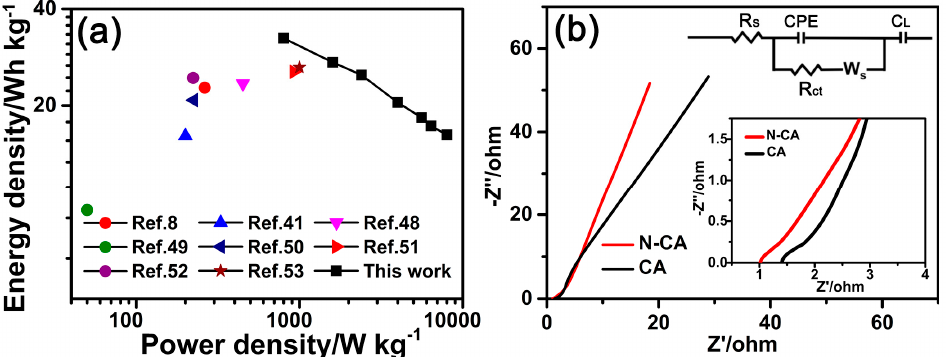
Figure 5. ( a ) Ragone plot of N-CA; ( b ) EIS tests of the CA and the N-CA. Upper inset: the electrical equivalent circuit that includes R s , R ct , a Warburg element W o , a pseudocapacitive element C L from redox processes and a constant phase element (CPE) accounting for EDLC; lower inset: enlarged view of the Nyquist plots.